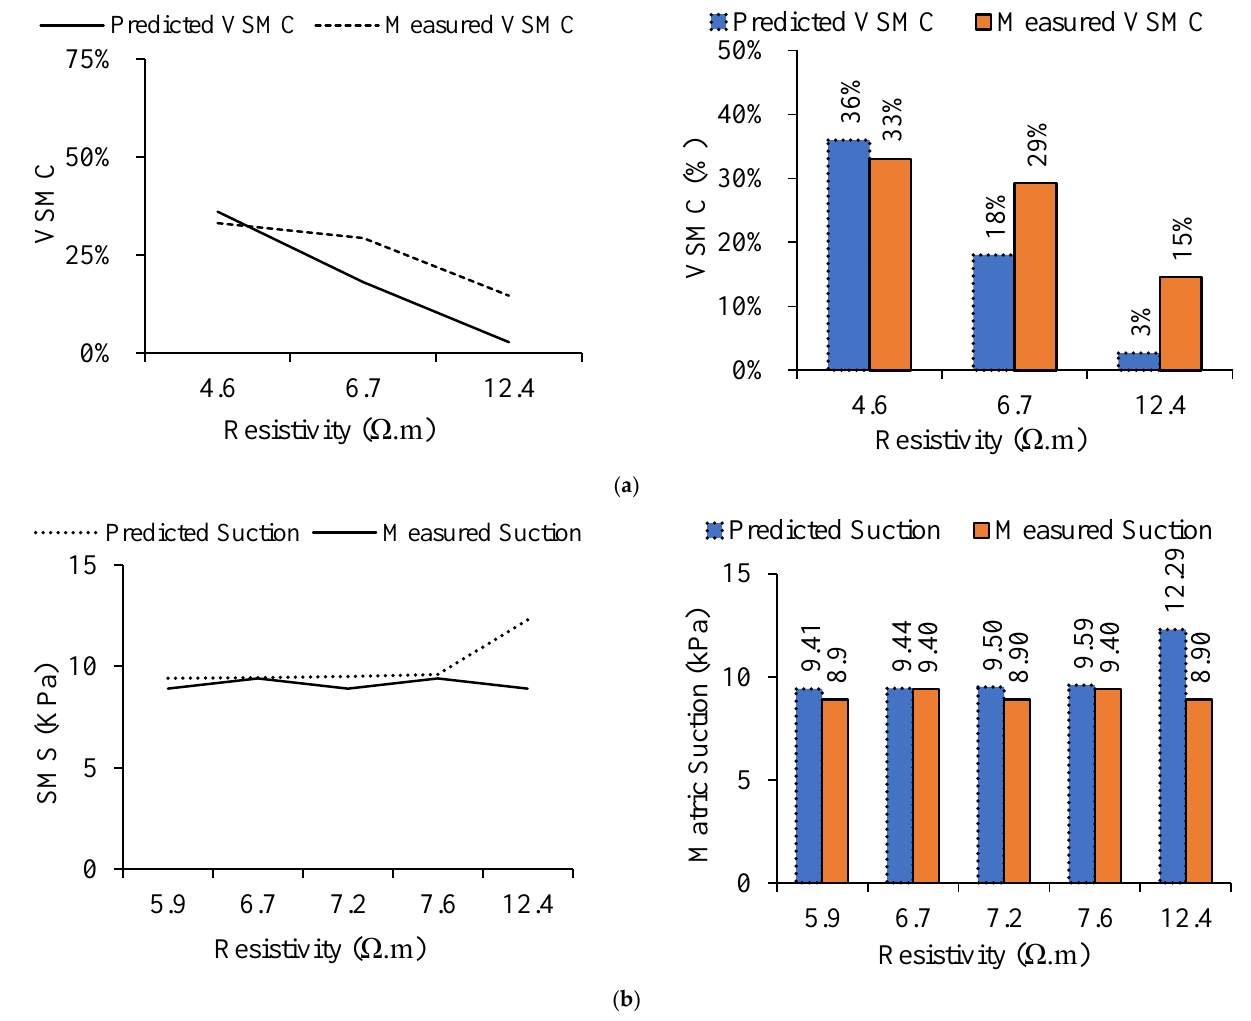
Figure 34. Validation of the developed field-based models ( a ) VSMC ( b ) SMS (1 kPa = 20.89 psf). To test the accuracy of the predicted models, a comparison of the predicted and meas- ured values for VSMC is presented in Figure 35. The prediction accuracy for VSMC is good (determination coefficient of 0.86), especially for the three data points for the crest of the slopes. The middle data of the VSMC predictions have been excluded as the expo- nential model predicted lower VSMC values compared to the measured ones. Figure 34d shows that over 80% of predicted SMS values matched with the measured values with minimal error margins. These results inspire confidence in the developed models to pre- dict VSMC and SMS through resistivity data obtained from the ERI investigation.